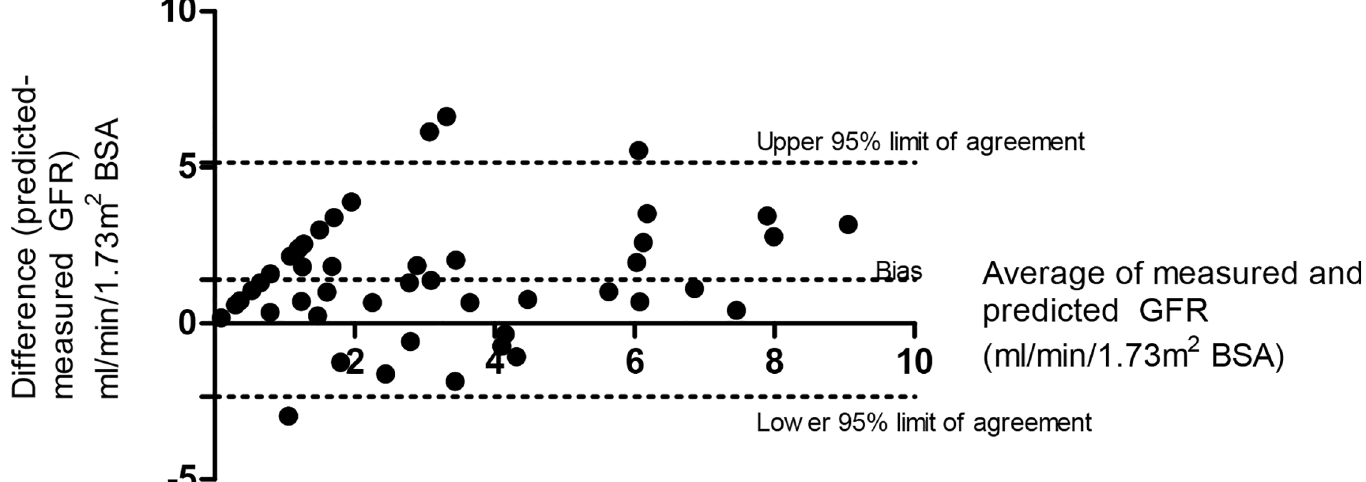
Fig 4. Bland-Altman analysis showing performance of Eq 1 for predicting GFR (ml/min/1.73m 2 BSA) based on pre-dialysis β 2-microglobulin plasma concentration.